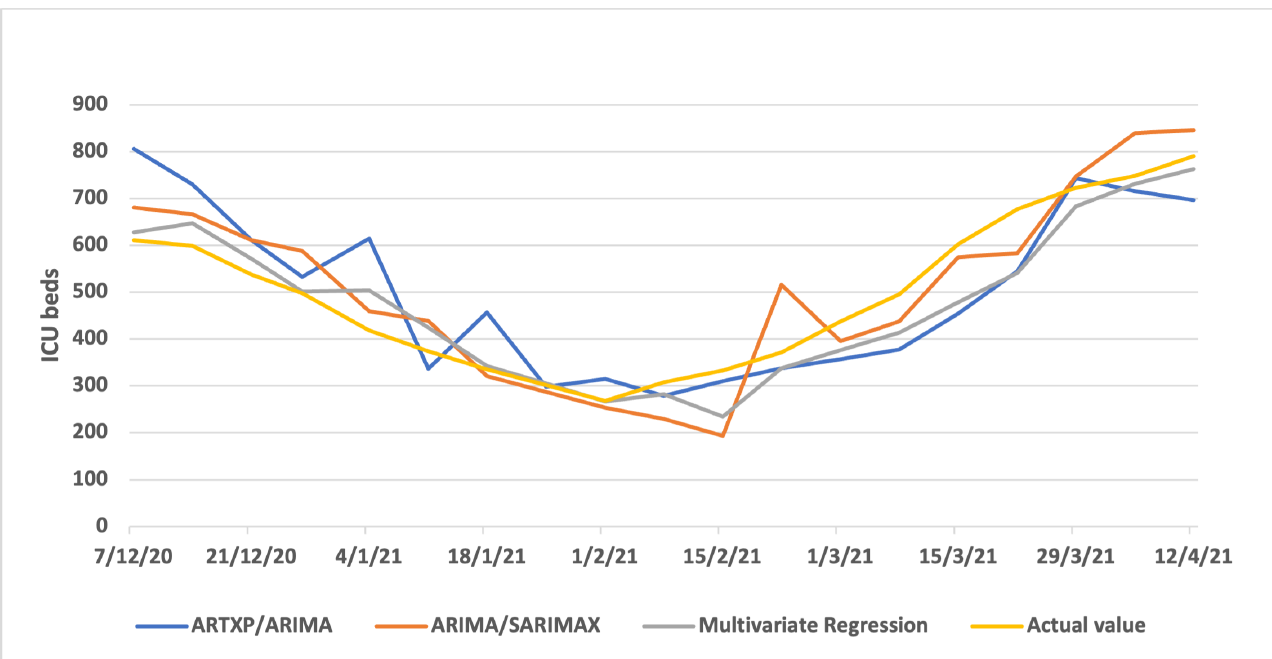
Figure A8. Two weeks Predicted vs. Actual